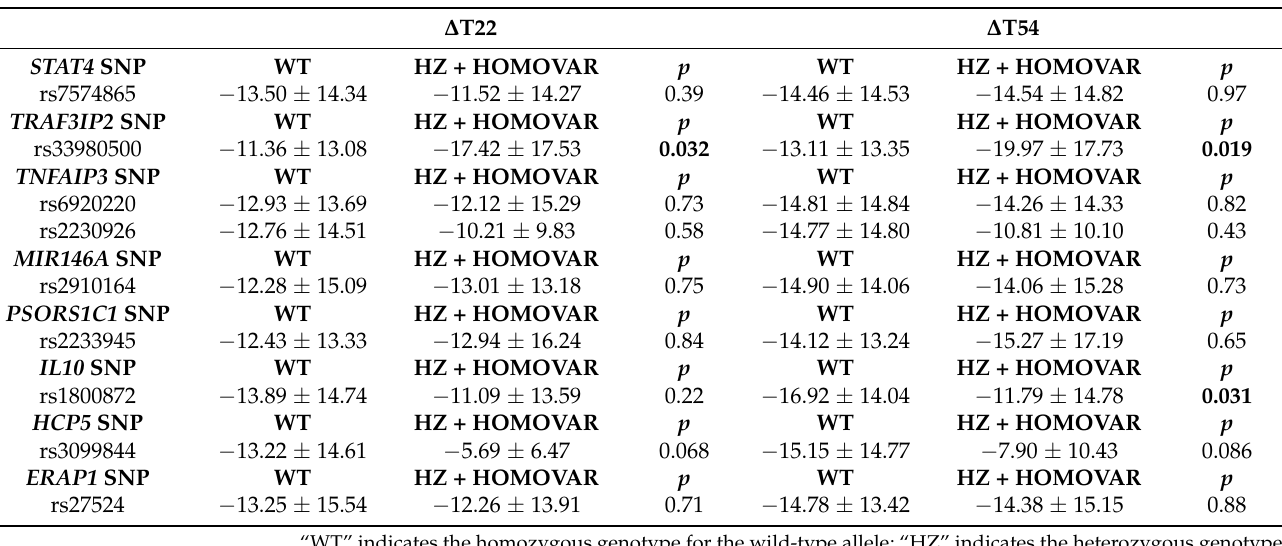
Table 2. Association analysis, according to the dominant model, for STAT4 , TRAF3IP2 , TNFAIP3 , MIR146A , PSORS1C1 , IL10 , HCP5 and ERAP1 polymorphisms and response to TNF-inhibitors treatment in PsA patients.